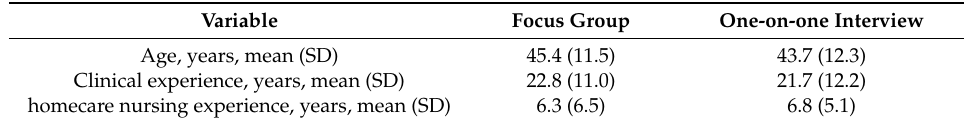
Table 1. The demographic of the participants.